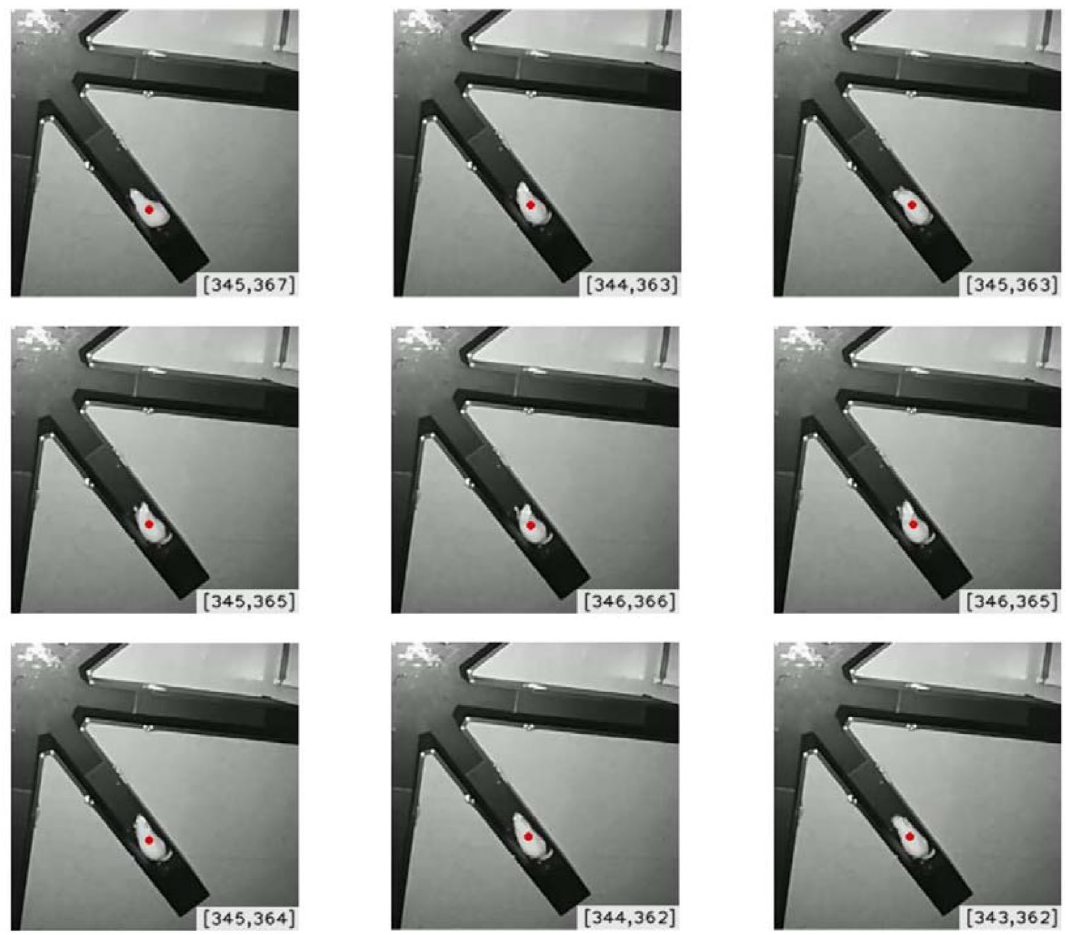
Figure 11. Illustration of an “S” spot regardless of small body